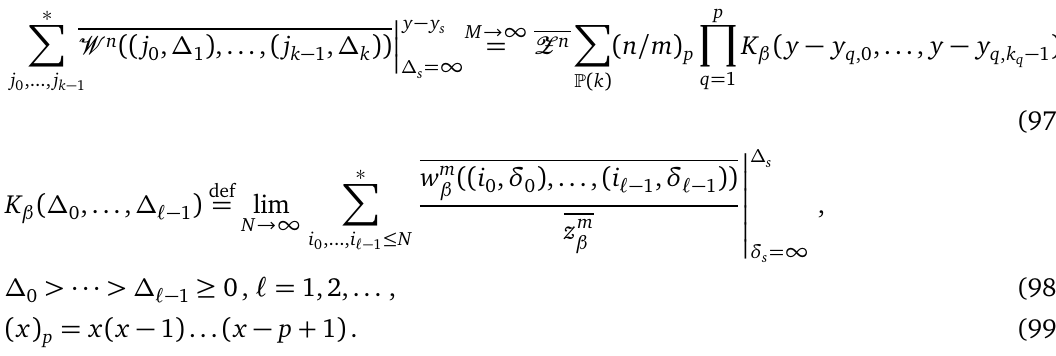
Figure 6: Illustration of the 5 partitions of { y each partition illustrates the corresponding position-value configuration: two minimum values y and y are in the same part if their position are close (technically, in the same block). Below s s (cid:48) each figure is written the corresponding partition (with shorthand notation s → y